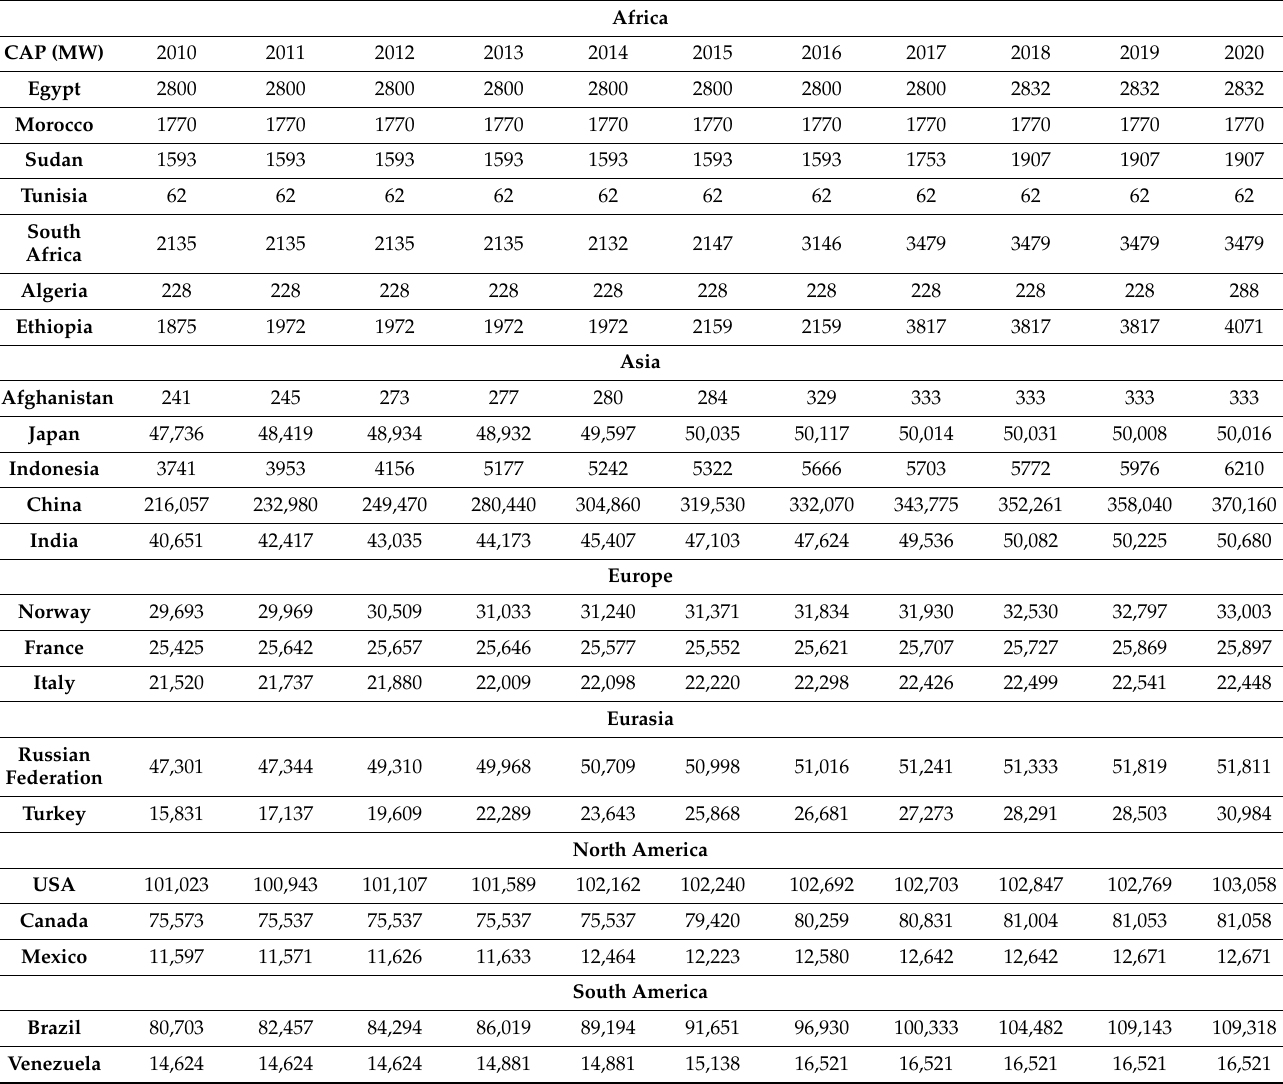
Table 2. Hydropower capacity of production in MW from 2010 to 2020 on different continents [18]. Africa